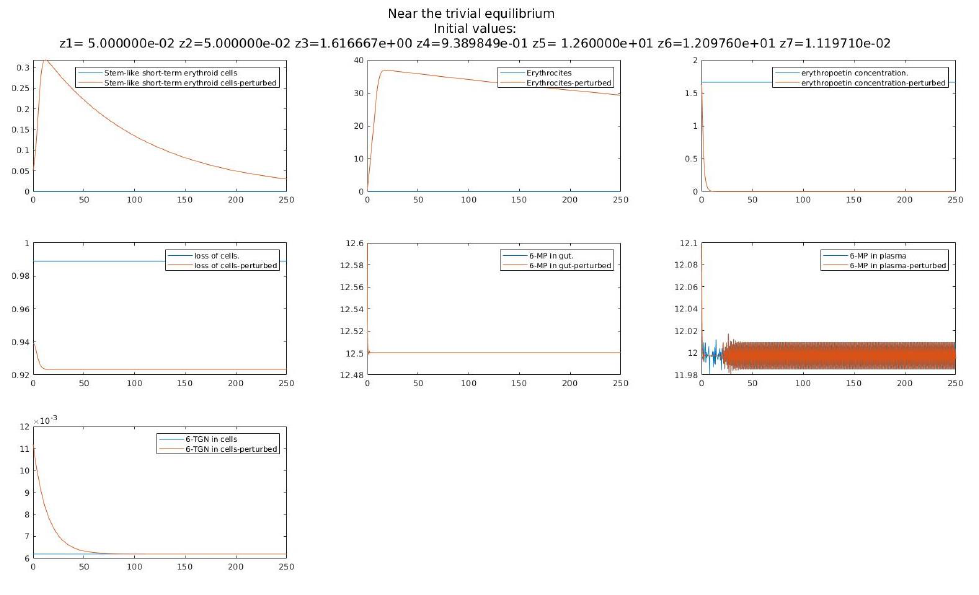
Figure 1. Stability of equilibrium point E 1 .